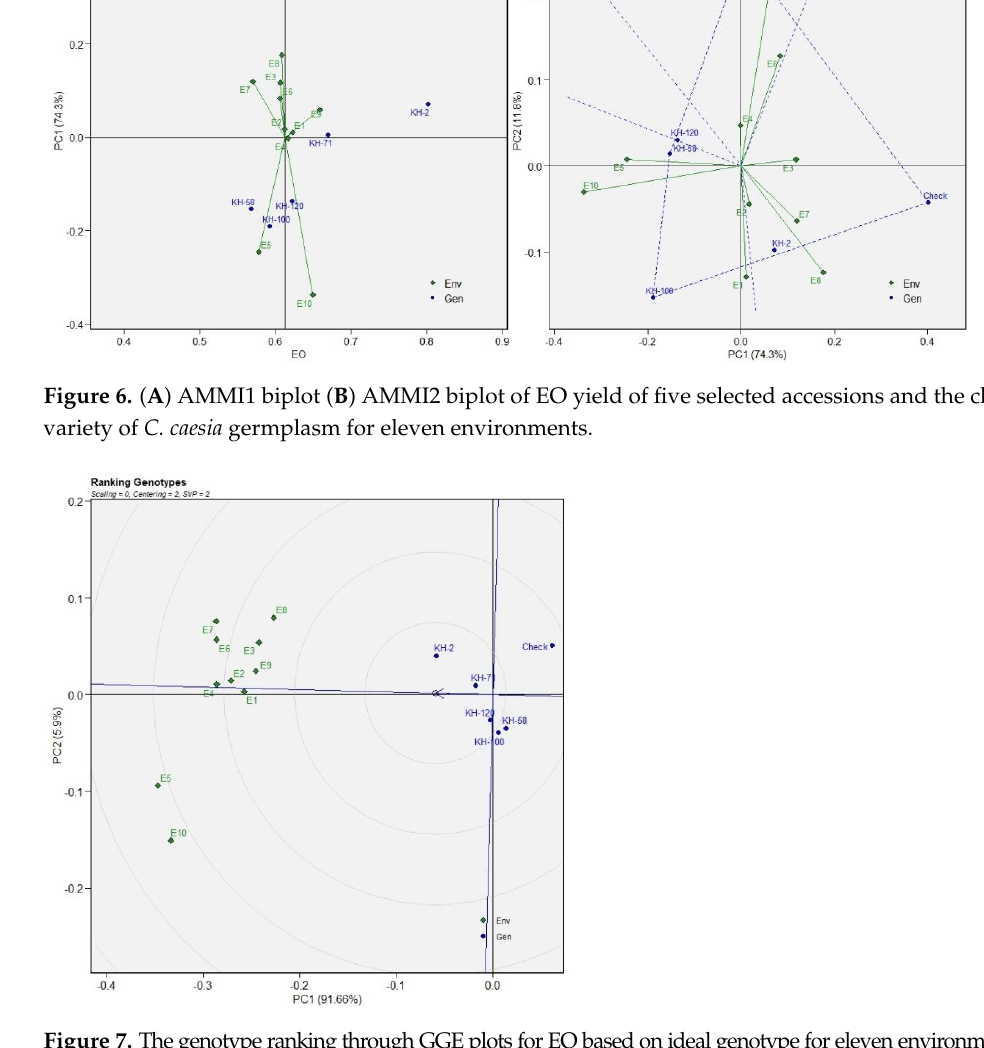
Figure 7. The genotype ranking through GGE plots for EO based on ideal genotype for eleven envi- ronments.